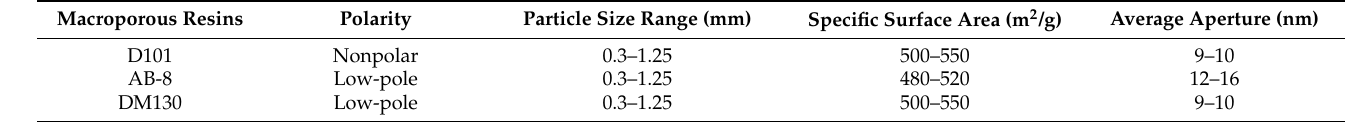
Table 3. The characteristics of three macroporous resins for total flavonoids from